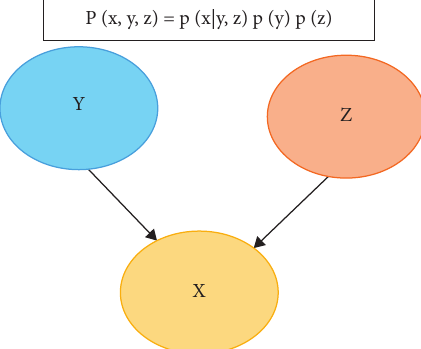
Figure 2: Sample influence